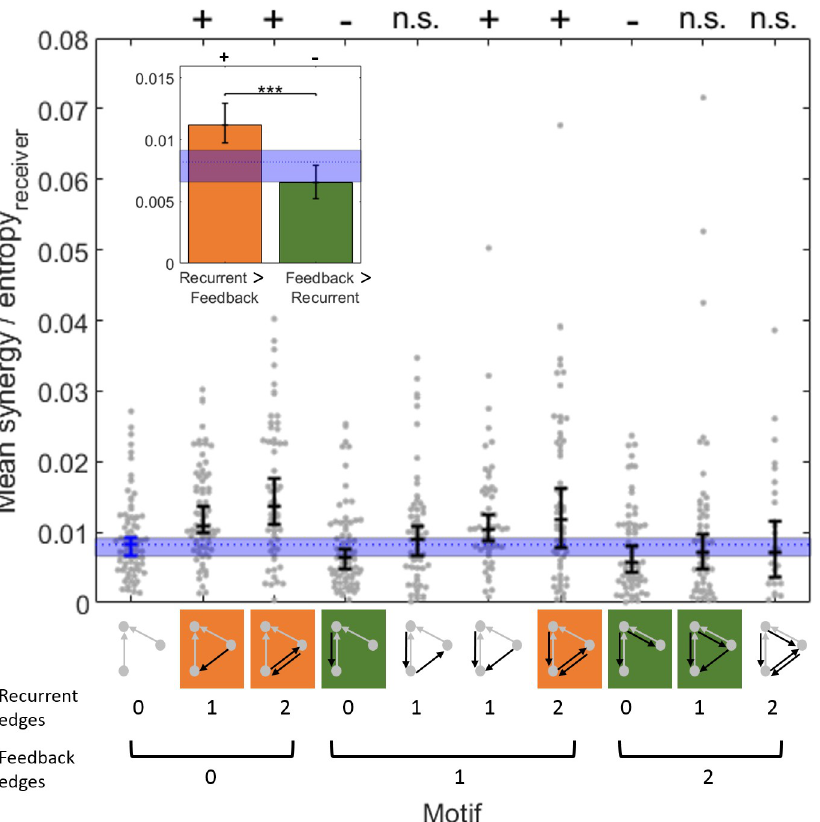
Fig 3. Normalized synergy was greater in recurrent motifs than in feedback motifs. Point clouds show the mean synergy value for each of the 75 networks analyzed for each type of motif. For distributions in which not all networks exhibited the motif, n < 75. Central tendency and error bars depict the median and the 95% bootstrap confidence interval around the median. The motifs are graphically depicted below the x-axis and are organized by the number of feedback and recurrent edges. Motifs with more recurrent than feedback edges are indicated in orange. Motifs with more feedback than recurrent edges are indicated in green. Inset: Synergy values from motifs with greater recurrence or greater feedback were aggregated to directly compare the mean synergy. In both panels, the median (dotted line) and 95% bootstrap confidence interval (blue region) for baseline synergy values in default motifs (with 0 recurrent and 0 feedback edges) is shown. Significance indicators: ‘+’ and ‘-’ indicates p < 0.01 by a two-tailed test wherein ‘+’ indicates significantly more than baseline and ‘-’ indicates significantly less than baseline; ��� p < 1x10 -9